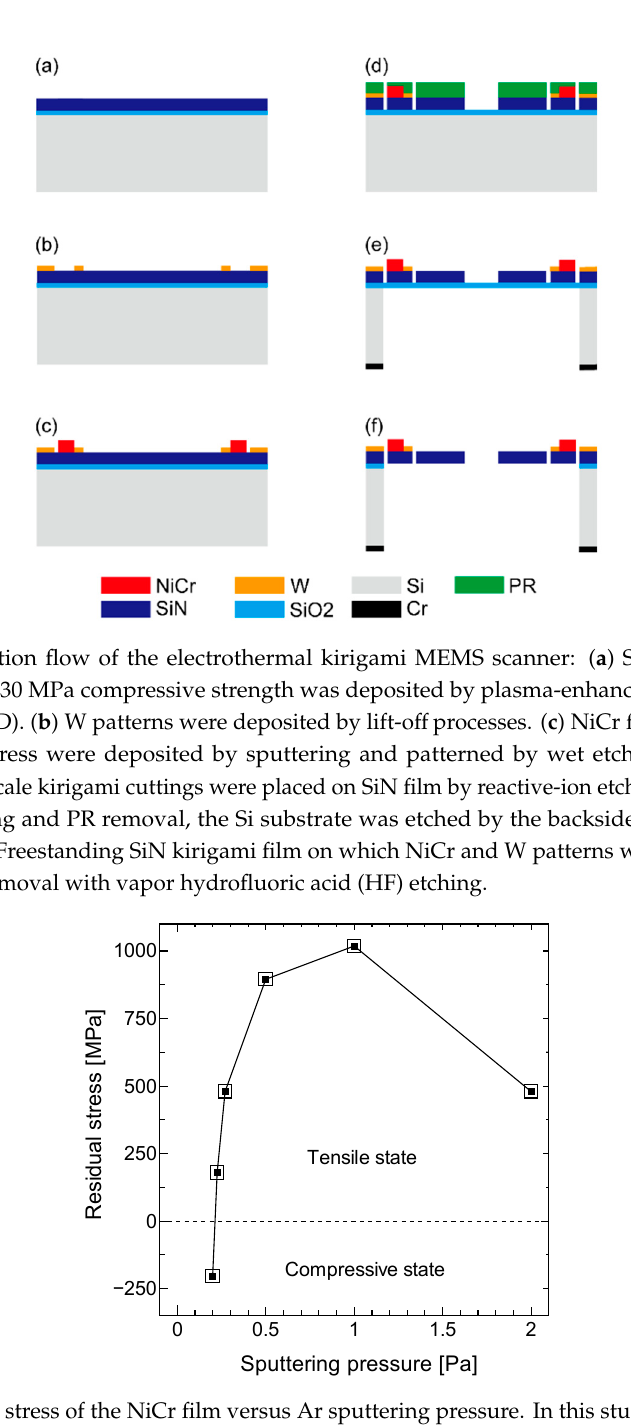
Figure 6. Residual stress of the NiCr film versus Ar sputtering pressure. In this study, the Ar pressure was set to 0.23 Pa for deposition of the NiCr film with 180 MPa tensile stress.